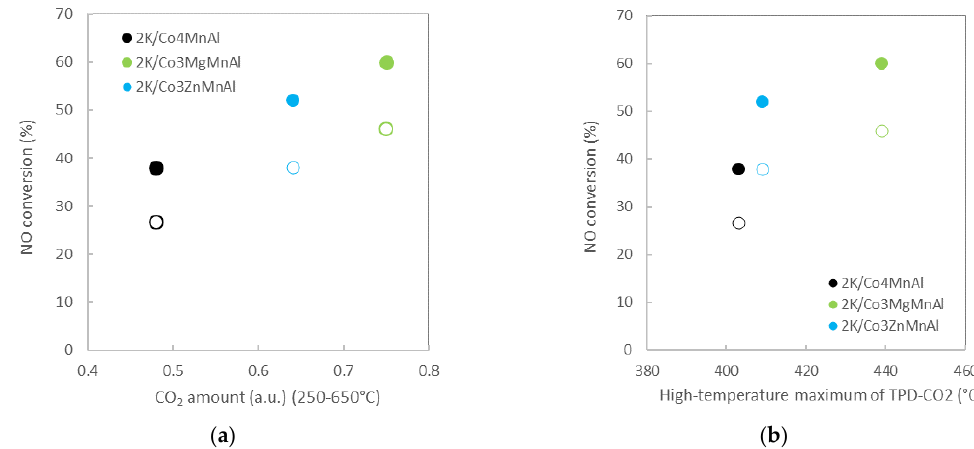
Figure 14. The dependence of NO conversion on: ( a ) the number of basic sites; ( b ) high-temperature maximum of TPD-CO 2 . Full mark — 700 °C, empty mark — 650 °C.